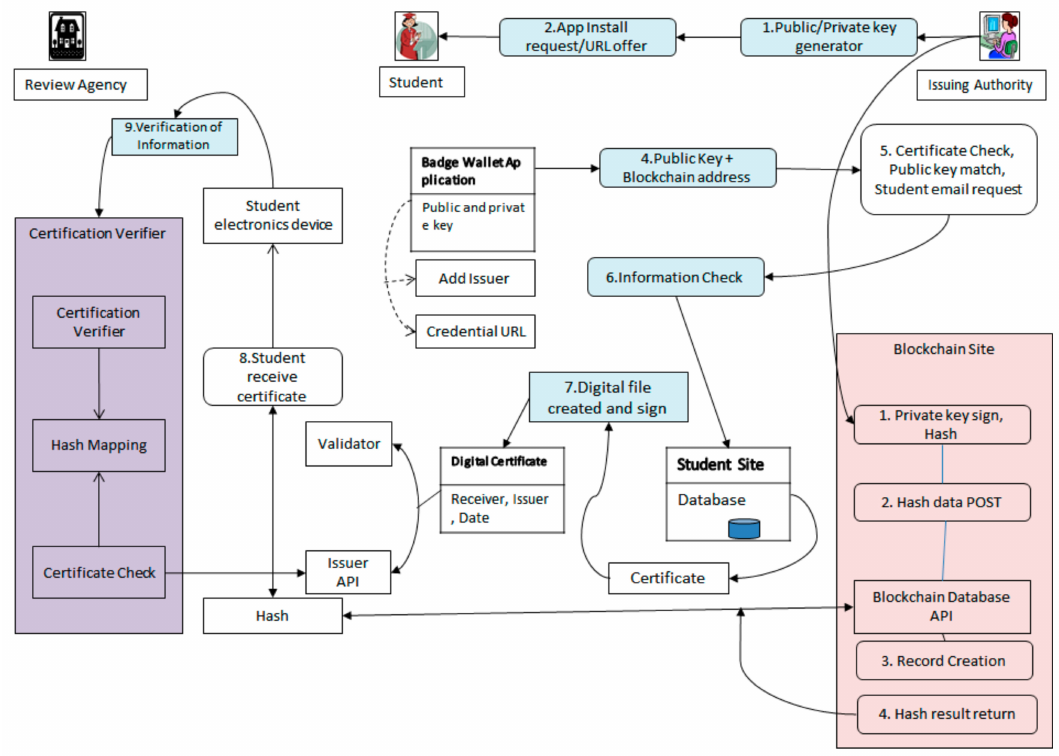
Figure 9. Flowchart of digital badge award and verification on our system implementation.